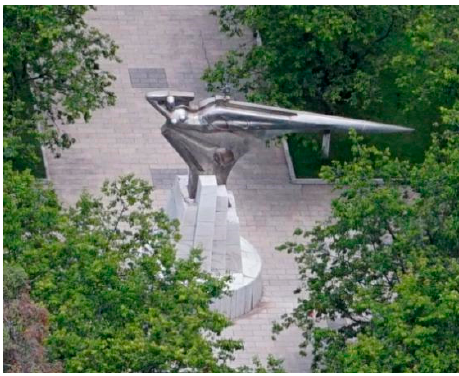
Figure 4. Status of the study area.